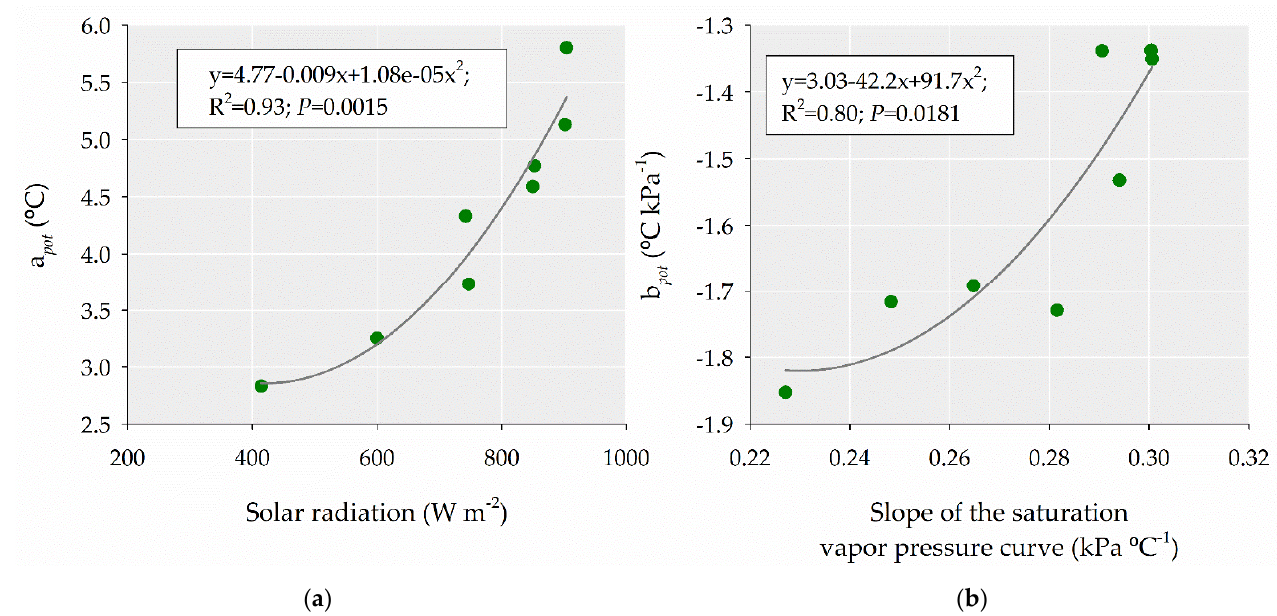
Figure 4. ( a ) Relationship between hourly a pot values and solar radiation; ( b ) relationship between b pot and the slope of the saturation vapor pressure curve. The curvilinear lines in ( a , b ) represent the best-fit regression lines.